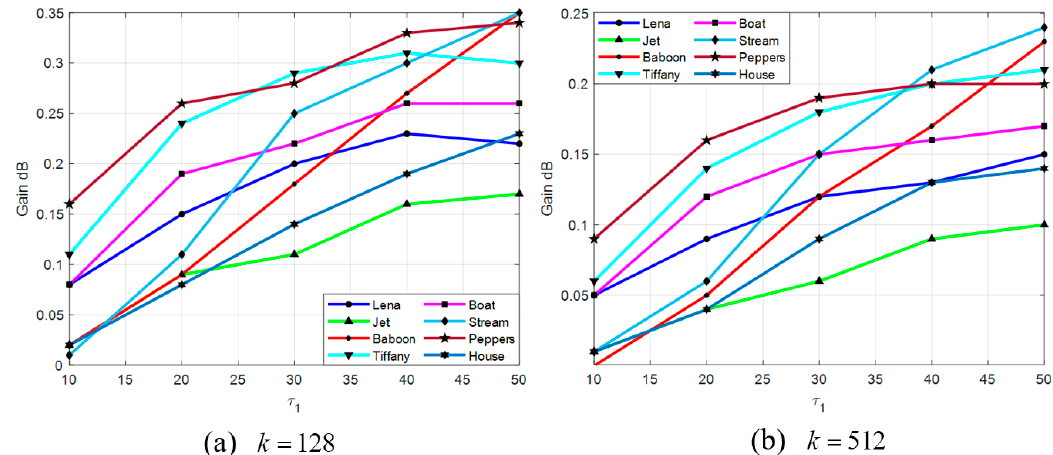
Figure 5. The gain of PSNR when the quantized value adjustment (QA) technique is applied.